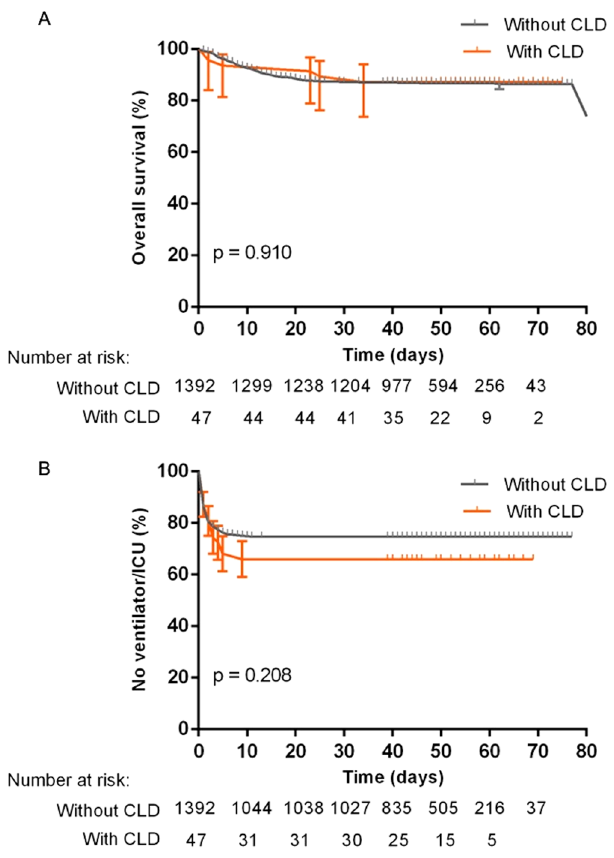
Figure 1. Kaplan–Meier survival curves of ( A ) overall survival, and ( B ) time to mechanical ventilation/ICU admission in COVID-19 patients with CLD or without